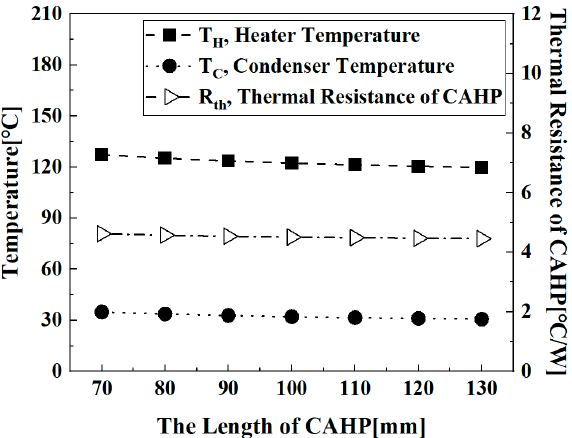
Figure 13. Simulated Thermal Characteristics of the CAHP according to length ( V air = 3 m/s, Q = 20 W, pitch angle = 0°, and roll angle = 0°).